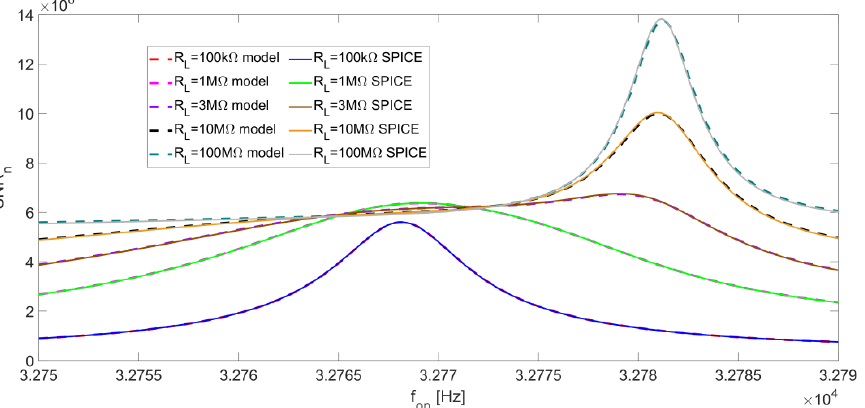
Figure 19. Total normalized signal-to-noise ratio SNR n at the LIA output as a function of the operating frequency, for different values of R L and at a low-pass filter bandwidth of BW = 5 Hz. The corresponding results of SPICE simulations are also reported.